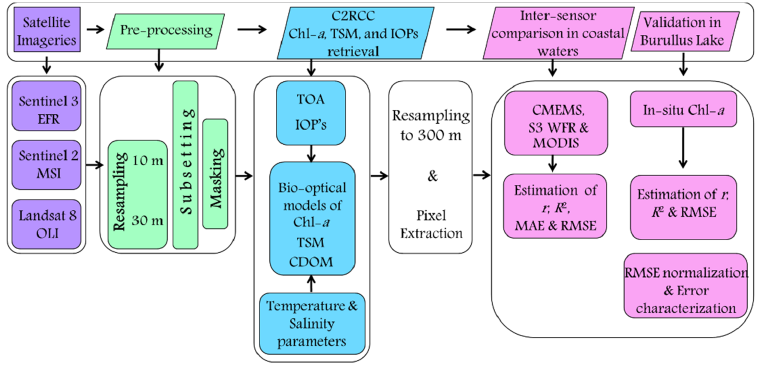
Figure 3. Flowchart of the adopted methodology. All sensor data were first masked for clouds and cloud shadows, and subsequently atmospherically corrected using the C2RCC atmospheric correction scheme. The algo- rithm runs on the visible-NIR bands (Table 2) commonly used for water color retrieval, with 5 bands for the OLI data, the MSI has 9 bands out of the sensor 13 bands at 10-60 m grid spacing, while OLCI has the 21 spectral bands in this region at a resolution of 300 m [81]. The satellite imageries were geometrically corrected to the UTM Zone 36, resampled, to 10 m resolution for MSI, 30 m for OLI, and 300 m for OLCI EFR; all were then subset to the study area. The land and cloud covers were masked using the metadata associated with the imageries. The atmospheric correction was then applied by appraising the use of the C2RCC algorithm implemented in the Sentinel Application Platform (SNAP) version 5.0 with the Sentinel-3 Toolbox Kit Module (S3TBX) version 5.0.1 for the three sensor data sets. Simply, C2RCC is based on water radiative transfer modeling and the vector succes- sive order of scattering (SOS) atmospheric model with aerosol optical properties derived from NASA AERONET-OC measurements [82,83]. The artificial neural network technol- ogy [84,85] is used where for every sensor data, a subset of bands is set as neural nets; the main net derives water-leaving reflectance ‘ ρ w ( λ )’ and the top-of-atmosphere (TOA) ρ toa ( λ ) radiances after atmospheric correction with an elaborate bio-optical ocean–atmos- phere model using a large database of water-leaving reflectances and relating to the opti- cal properties from various coastal areas around the world. Subsequently, the trained neu- ral nets parametrize the inverse relationship between inherent optical properties (IOPs) and reflectances (water-leaving ρ w ( λ ) from the ρ toa ( λ )), allowing the retrieval of certain water quality parameters, such as chlorophyll -a , TSM, and the CDOM [86]. For all combination of the IOP components, based on a large world database of radi- ative transfer simulations in natural waters as “truth”, and the trained IOP inversion net as “estimate”, the difference between truth and estimate gives the uncertainty per IOP per pixel in the image [82], defined here as the associated error of the water color constituent. C2RCC proved applicable to a wide range of satellite sensors, such as SeaWiFS, MERIS, MODIS, OLI, MSI, and OLCI [85], and efficient in many world case studies for the retrieval of Ocean Color estimates; detailed information on processing is given in Brockmann et al. [85]. For the C2RCC implemented in SNAP, the local relationship between IOPs and con- centrations of optical substances in the water that are regionally variable can be adjusted